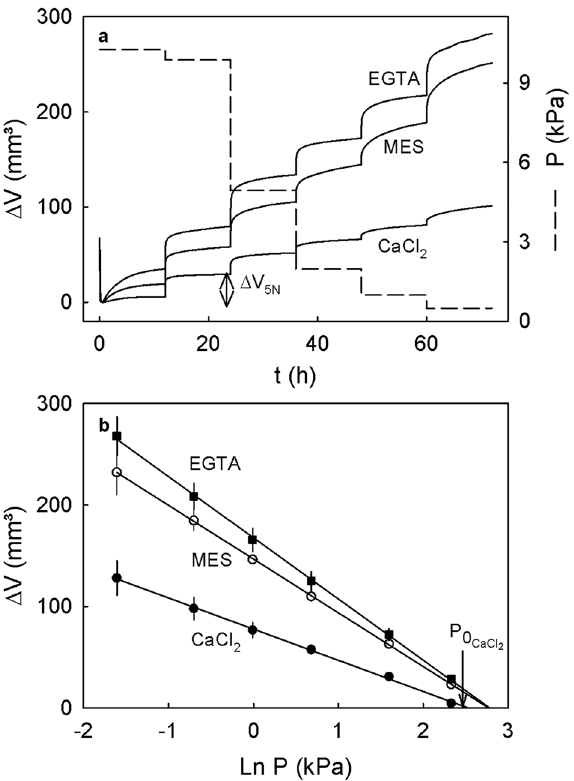
Figure 5. Effect of a stepwise decrease in pressure on swelling of extracted cell walls of mature ‘Burlat’ sweet cherry fruit. Cell walls were allowed to swell in the presence of buffered 10 mM CaCl 2 , buffered 5 mM EGTA or buffer only. The buffer was 10 mM MES at a pH of 5.8. Swelling was quantified in vitro as the change in volume (∆V) of the extracted cell walls as the pressure applied to the cell walls was decreased. ( a ) Time course of change in pressure and change on volume of cell walls as the pressure was decreased stepwise from 10.3 to 0.1 kPa. At each pressure step, the pressure was held constant for 12 h to allow equilibration of cell wall swelling. ( b ) Relationship between the swelling of cell walls (∆V) at equilibrium and the natural logarithm of the applied pressure. The swelling pressure P 0 corresponds to the pressure at which no swelling occurs. The value P 0 was estimated as the x-axis intercept of a regression fitted through a plot of ∆V vs. ln P. The change in cell wall volume per unit pressure represents the slope of this regression and may be interpreted as a volumetric modulus of elasticity of the cell wall.